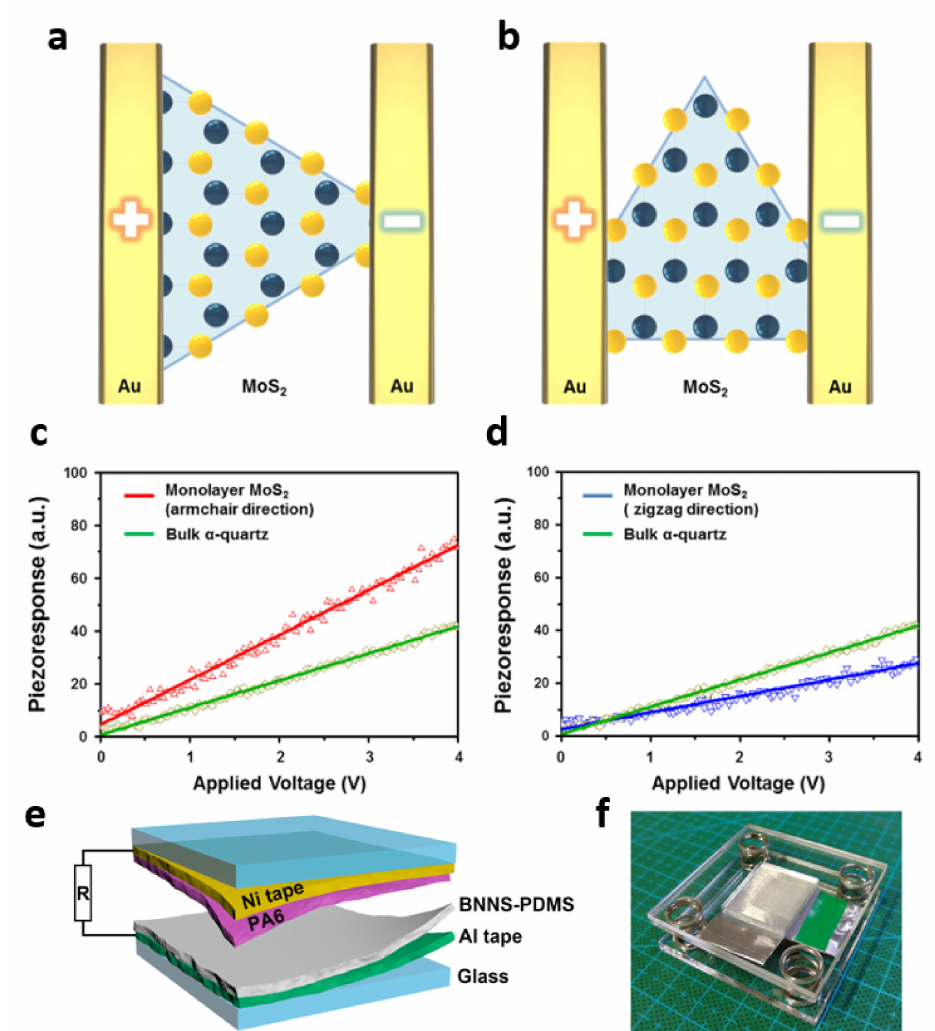
Figure 7. Corresponding piezoelectric modulus (d11) for monolayer MoS 2 flakes and electrode positions in ( a ) the armchair direction and ( b ) the zigzag direction. High distinct piezoelectric response for monolayer MoS 2 and α -quartz in ( c ) the armchair direction and ( d ) the zigzag direction. Reproduced with permission from [70], Copyright 2016, Elsevier. ( e ) A 3D schematic and ( f ) a photograph of the integrated PTEG device. Reproduced with permission from [71], Copyright 2020,